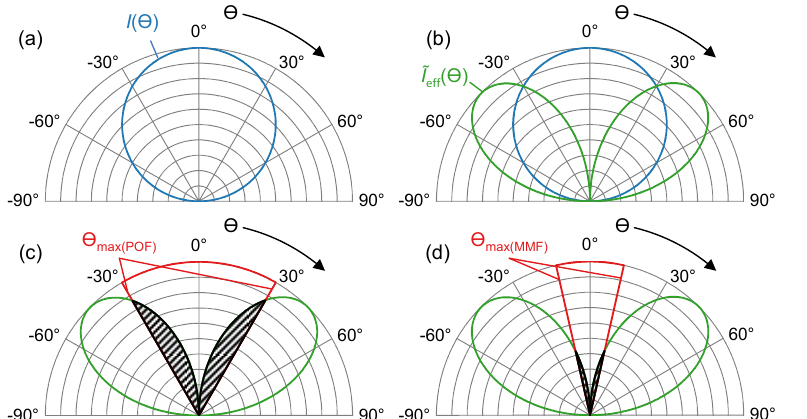
Figure 6. Graphic representation of the coupling efficiency regarding the acceptance angle: (a) blue line: Lambertian radiation pattern of the LED I ( (cid:50) ); (b) green line: normalized effective radiant intensity e I eff ( (cid:50) ) of the LED; (c) hatched area: fiber-coupled power P F for a POF with NA = 0.5 limited by the corresponding acceptance angle (red line); (d) hatched area: fiber-coupled power for a silica multi-mode fiber (MMF) with NA = 0.22 (red line).